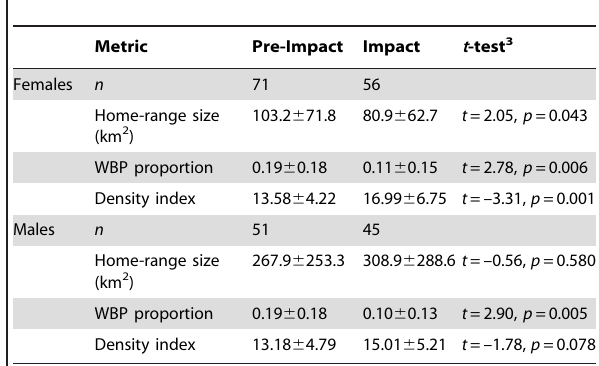
Table 1. Metrics 1 of home-range size 2 , proportion whitebark pine (WBP; adjusted for mortality during impact period), and density index associated with female and male grizzly bear home ranges in the Greater Yellowstone Ecosystem during periods.